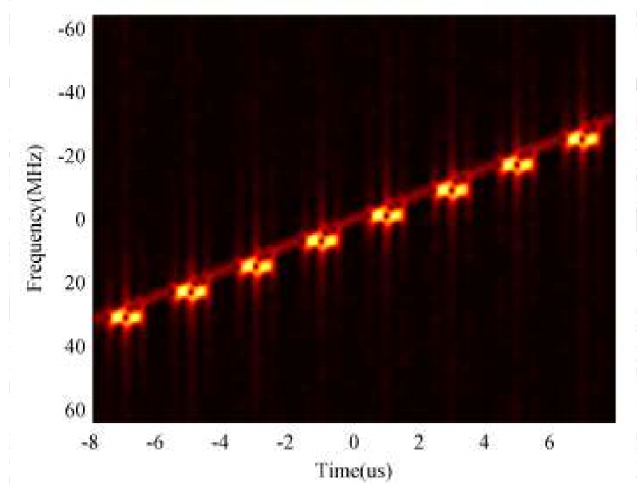
Figure 7. STFT results of LMF echo signal.